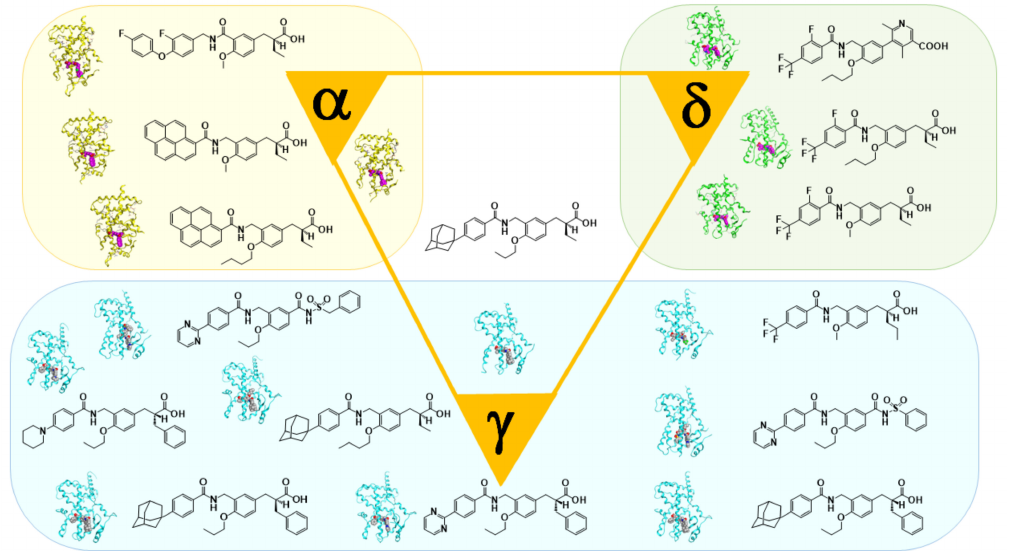
Figure 2. Structures of PPAR γ agonist pioglitazone (1), PPAR α agonist fenofibrate (2), and PPAR δ agonist GW-501516 (3), and, below, our PPAR agonists.